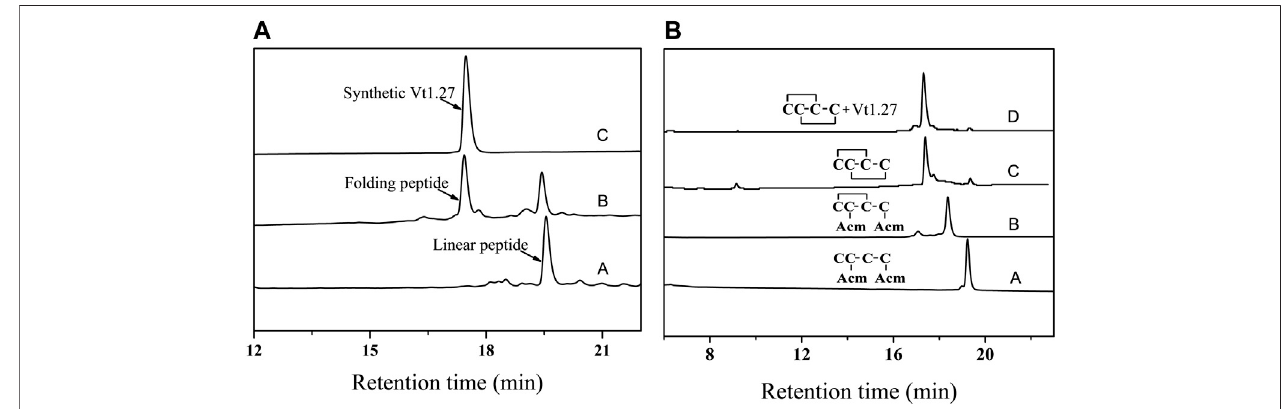
FIGURE 1 | HPLC analyses of folded products of linear and Acm-modi fi ed Vt1.27. A. Folded products of linear Vt1.27: (A) Linear peptide; (B) One-step oxidized products; (C) Puri fi ed product of Vt1.27; B: (A) Linear peptide with Acm modi fi cations at Cys2 and Cys 4; (B) First oxidized product; (C) Second oxidized product; (D) Co-elutionofthe two-step folding products and the puri fi ed product Vt1.27. Sampleswere applied toa Calesil ODS-100C 18 column (4.6 mm × 250 mm) and eluted by applying a 24 min linear gradient of 10 – 50% acetonitrile (0.1% TFA) at a fl ow rate of 1 ml/min, 214 nm.